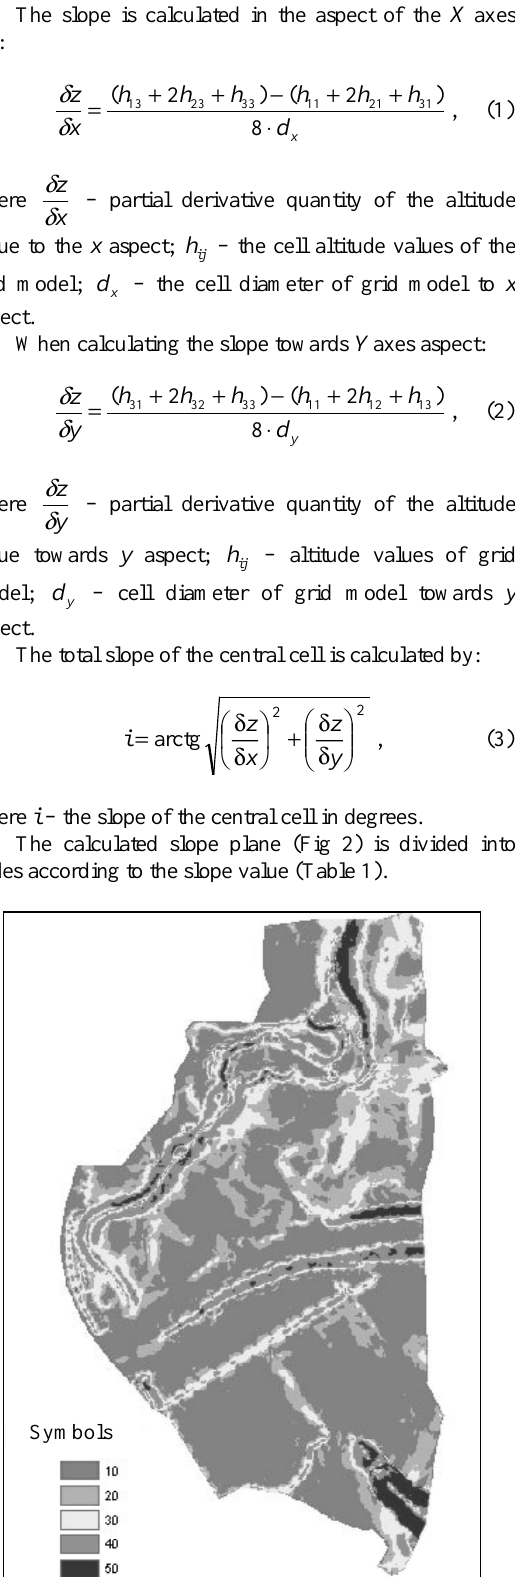
Fig 4 . Aspect classification by grid data